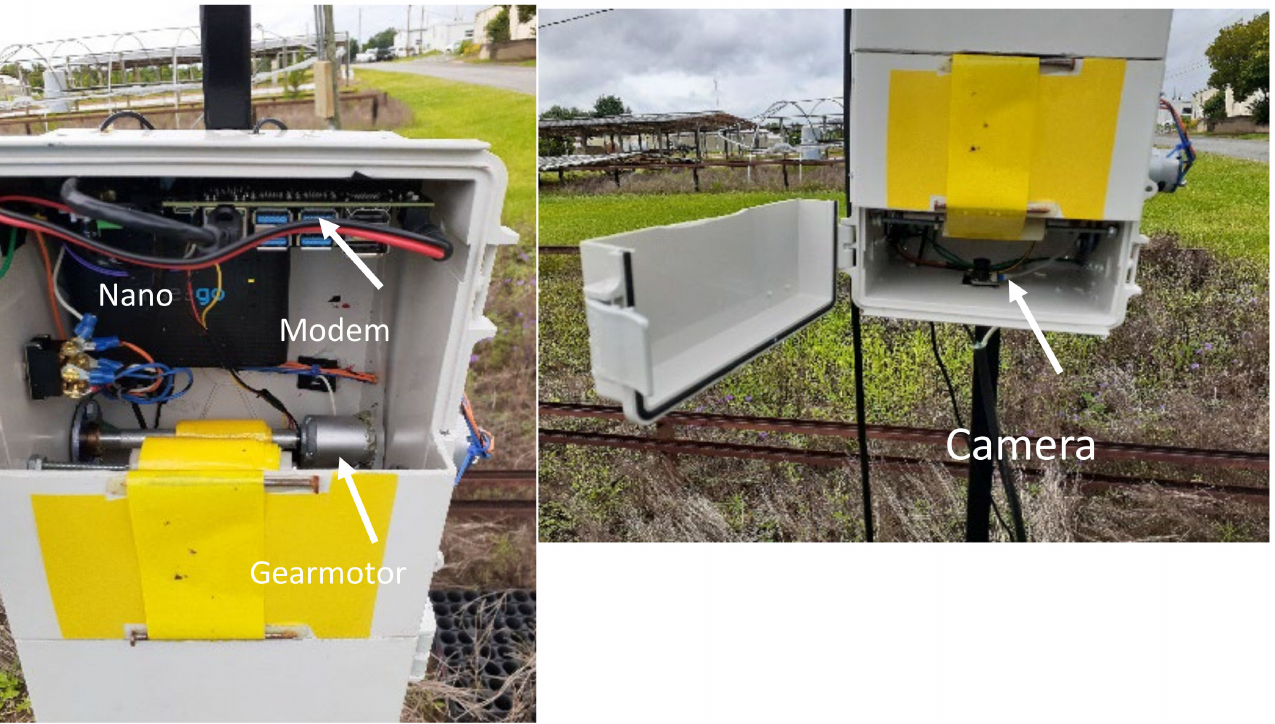
Figure 1. The web-RAID station opened at the top ( left ) and bottom ( right ) to see the main compo-